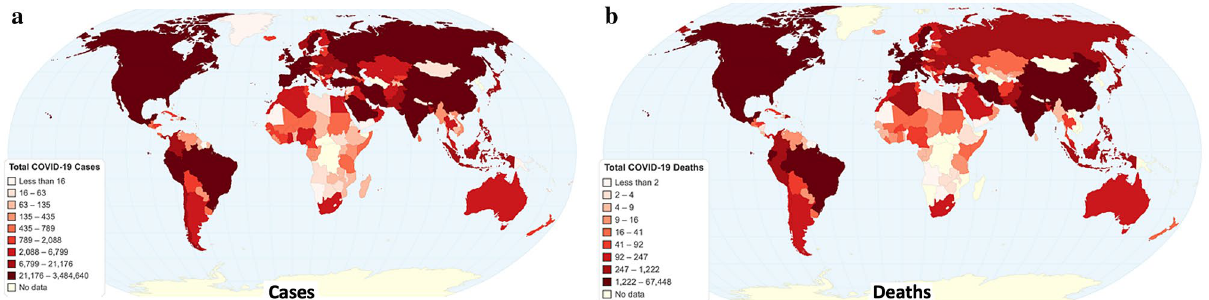
Figure 1. Cumulative worldwide COVID-19 ( a ) cases and ( b ) deaths (Chartsbin 22 ).